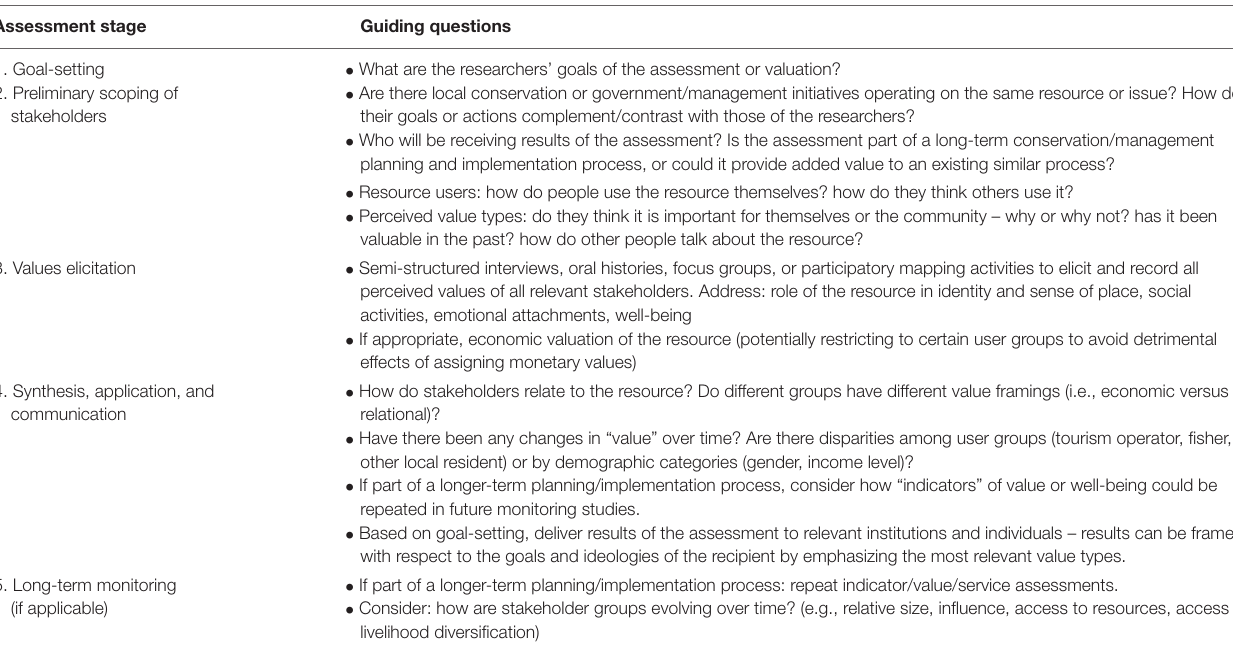
TABLE 2 | Guiding workflow to conduct a holistic values assessment, whether as an independent study, or as a component of a longer-term planning/implementation